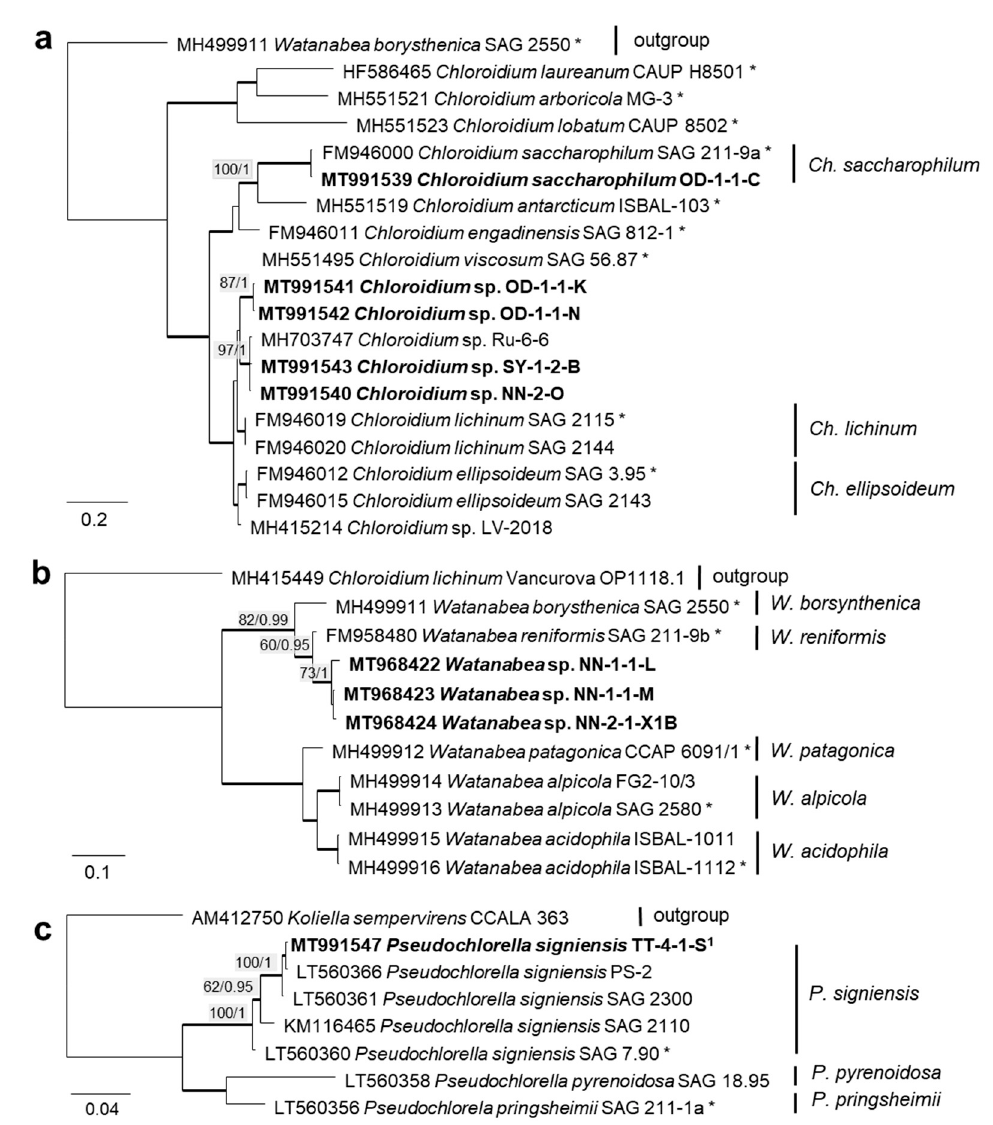
Figure 9. Molecular phylogeny of the Trebouxiophyceae genera based on ITS-1,2 sequencing (2). ( a ) Chloroidium , ( b ) Watanabea , and ( c ) Pseudochlorella . The phylogenetic tree was calculated by the Bayesian method, including posterior probabilities (PP) with additional maximum likelihood bootstrap values (BP); branches are supported by both methods in bold (BP > 60% and PP > 0.9). Authentic strains were marked with an asterisk, original strains from this study in bold. 1 Identical to Pseudochlorella signiensis TSN1 (MT968421) and TSN3 (MT991546).